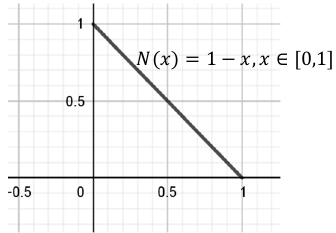
Figure 2. Strong negation via line.